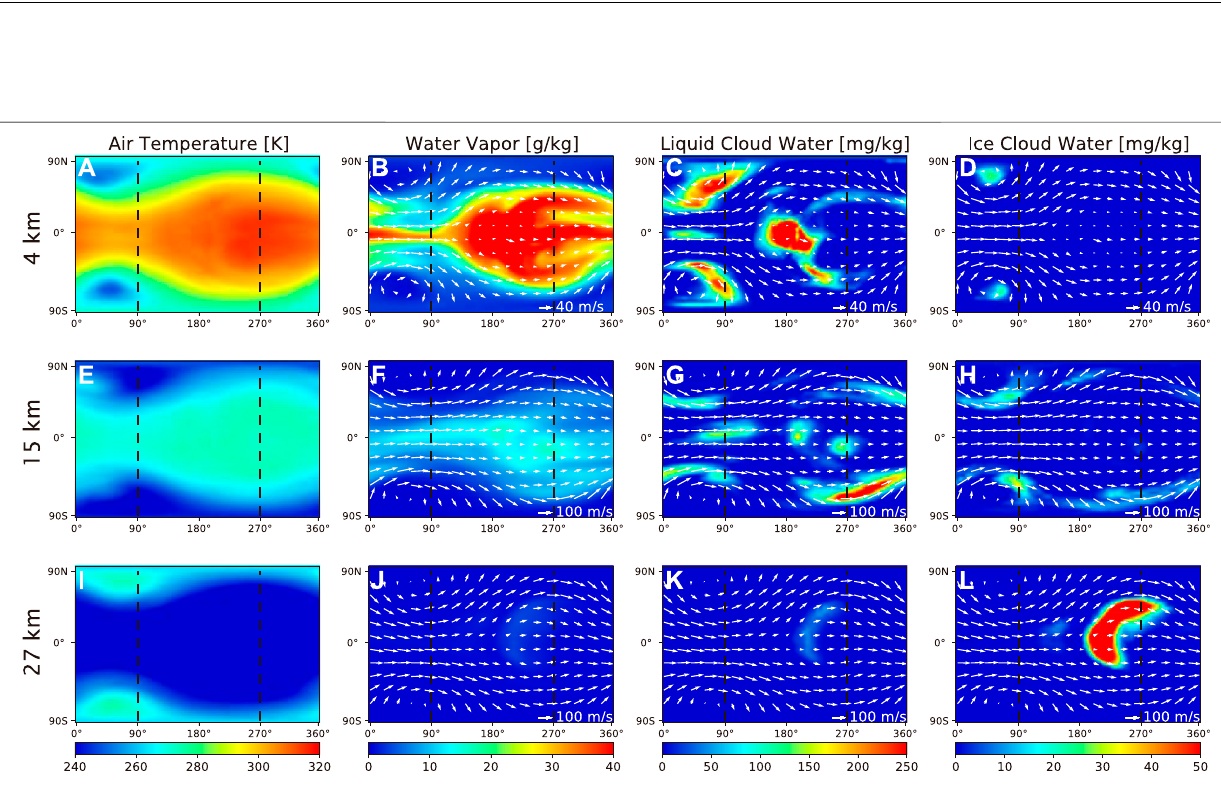
FIGURE 4 | Spatial patterns of surface temperature (the fi rst column), water vapor concentration (the second column), liquid cloud water concentration (the third column), and ice cloud water concentration (the fourth column) in one time snapshot at three different levels (4, 15, and 27 km), for the rapidly rotating planet of